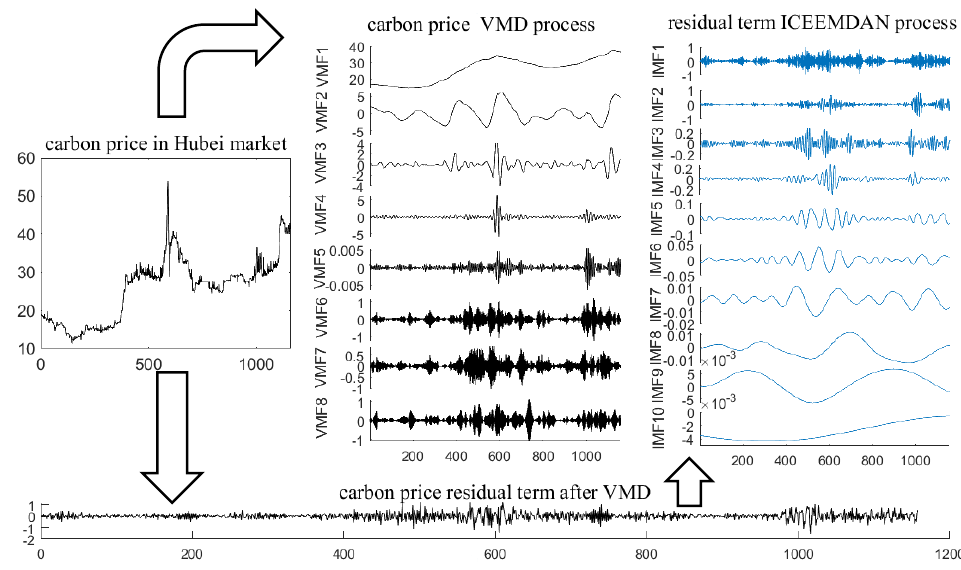
Figure 2. Secondary decomposition of the carbon price using VMD ‐ ICEEMDAN.